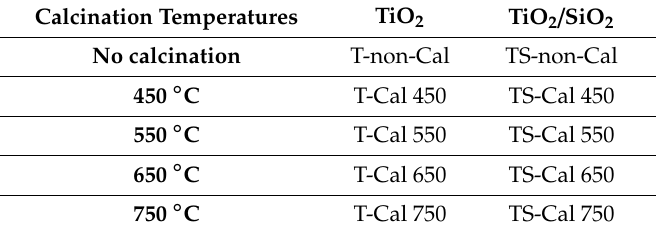
Table 5. Calcination temperature and label of prepared TiO 2 and TiO 2 / SiO 2